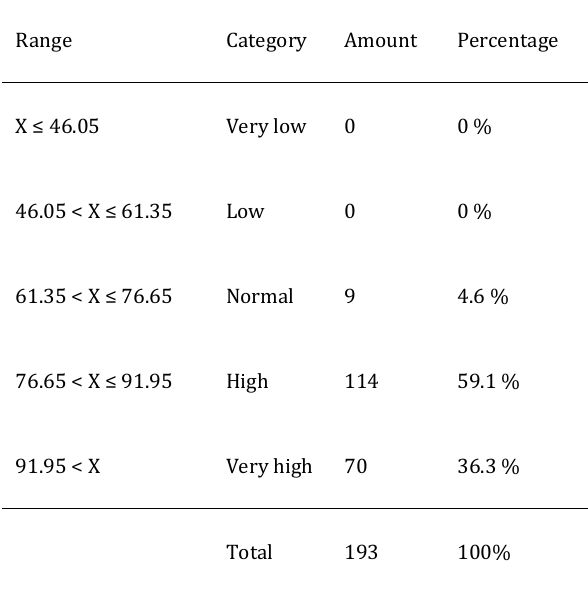
Table 11 The categorization of the intrapreneurship score